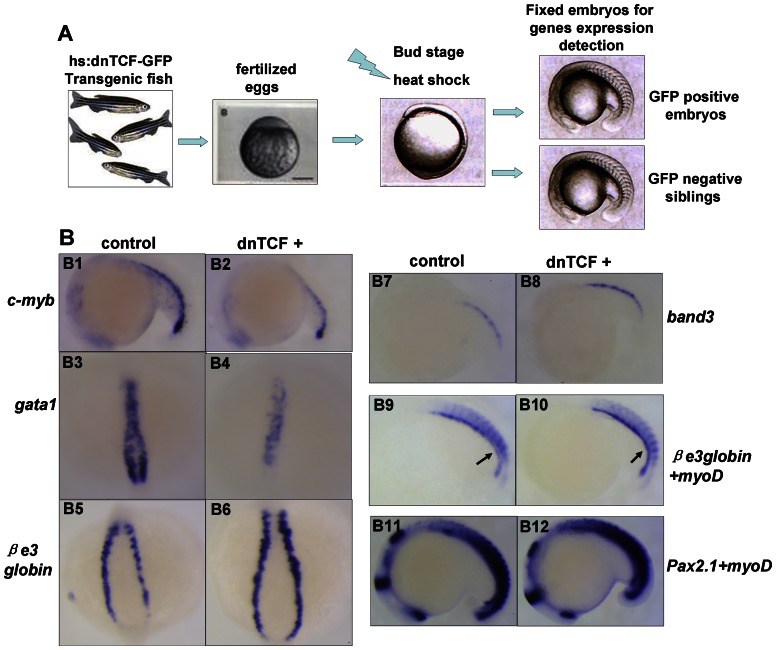
Knockdown Wnt signaling in hs:dnTCF-GFP embryos by heat shock at the bud stage resulted in reduced progenitor cells and accelerated differentiation of erythroid cells.(A) Scheme of using hs:dnTCF-GFP fish to knockdown Wnt signaling in embryos. (B) Reduced progenitor blood cells, labeled by c-myb (B1, B2) and gata1 (B3, B4), but accelerated erythroid cells differentiation, labeled by βe3 globin (B5, B6, B9, B10) and band3 (B7, B8) displayed in hs:dnTCF-GFP positive embryos, and black arrow indicate the increased expression of βe3 globin expression in hs:dnTCF-GFP positive embryos (B10) compared to its control siblings (B9). Other mesoderm, labeled by pax2a and myoD (B9, B10, B11, B12), was normal in hs:dnTCF-GFP positive embryos. B1, B2, B7–B12, lateral view, anterior to the left; B3–B6 dorsal view, anterior to the up.